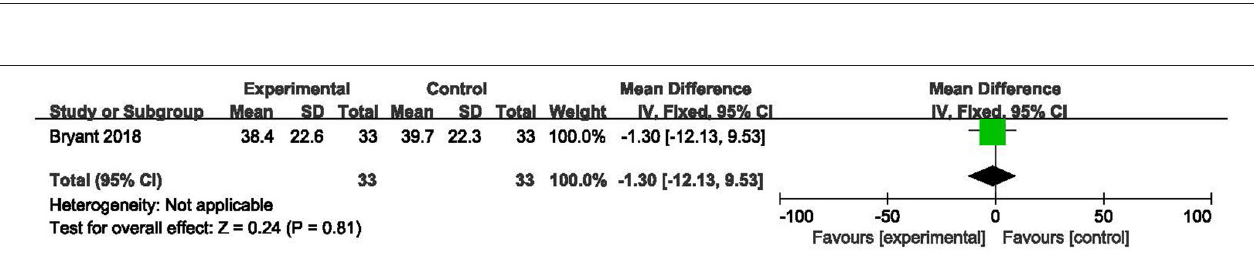
FIGURE 3 | Forest plot of network meta-analysis of the end-of-treatment effect on post-traumatic stress disorder symptom severity between cognitive behavioral therapy-long and no treatment.